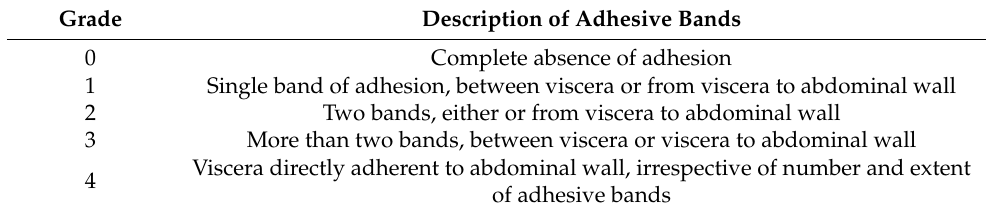
Table 2. Adhesion score system for macroscopic